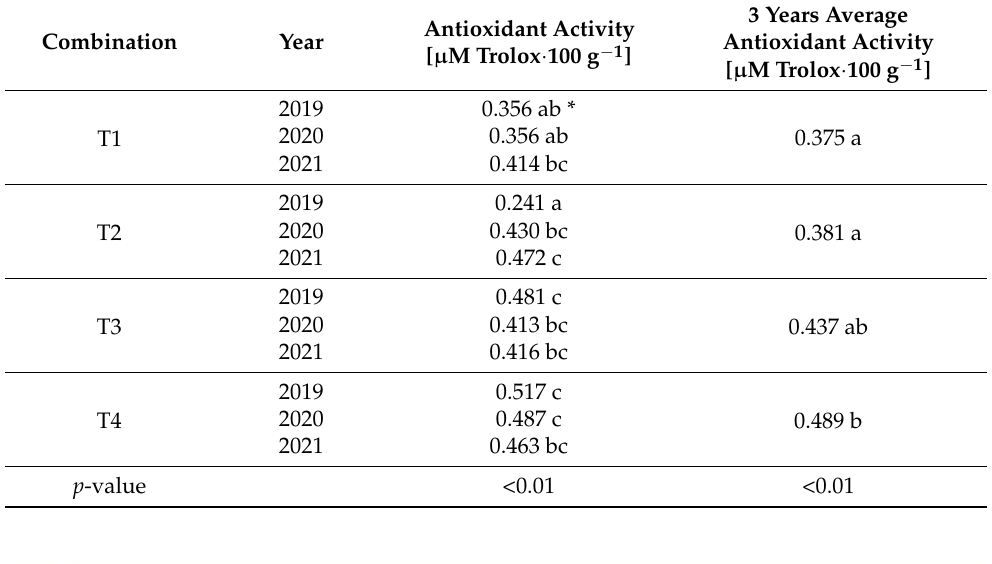
Table 4. Influence of fertilization technology on antioxidant activity—data averaged over the years of the study. * Data followed by the same letter are not significantly different.